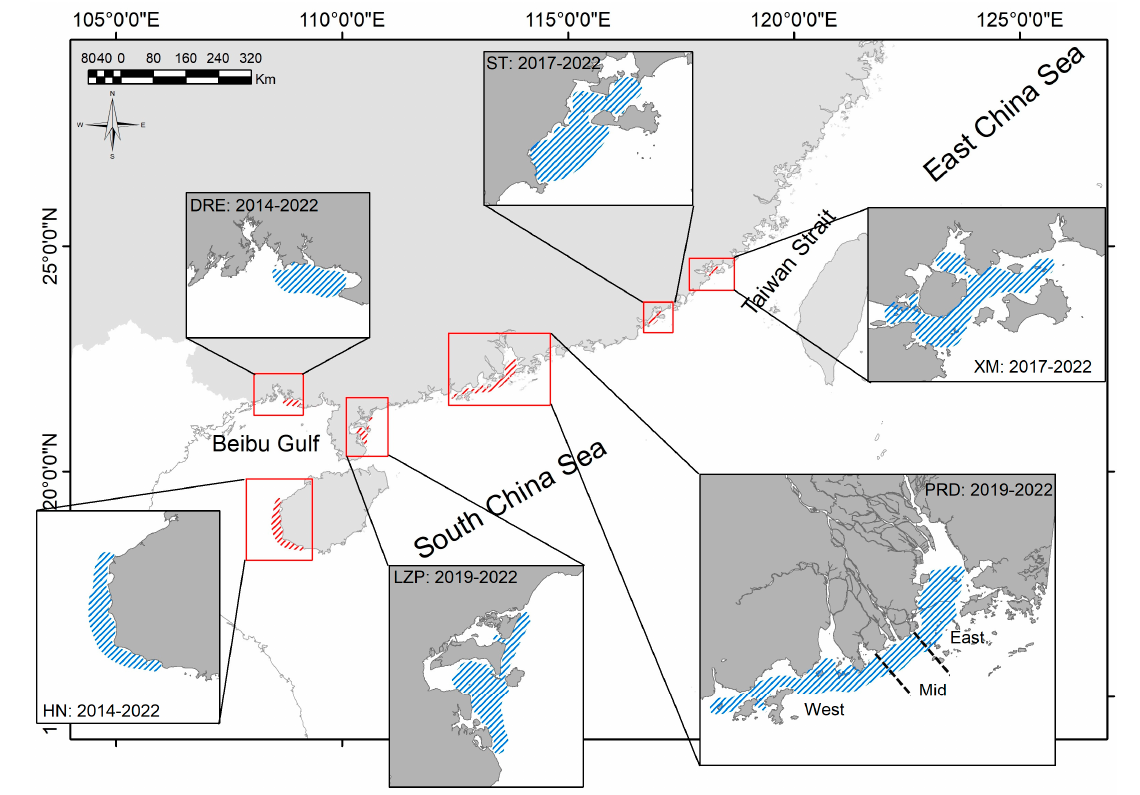
Figure 1. Six Indo-Pacific humpback dolphin populations off southern China covered by this study effort, including: Xiamen Habor (XM), the coastal waters off Shantou City (ST), the Pearl River Delta region (PRD, which was further divided into the East, Mid, and West sections by the dashed lines), the east coast of Leizhou Peninsula (LZP), the southwestern coast of Hainan Island (HN), and the Dafeng River Estuary and its surrounding waters (DRE). The sampling periods are indicated for each location.